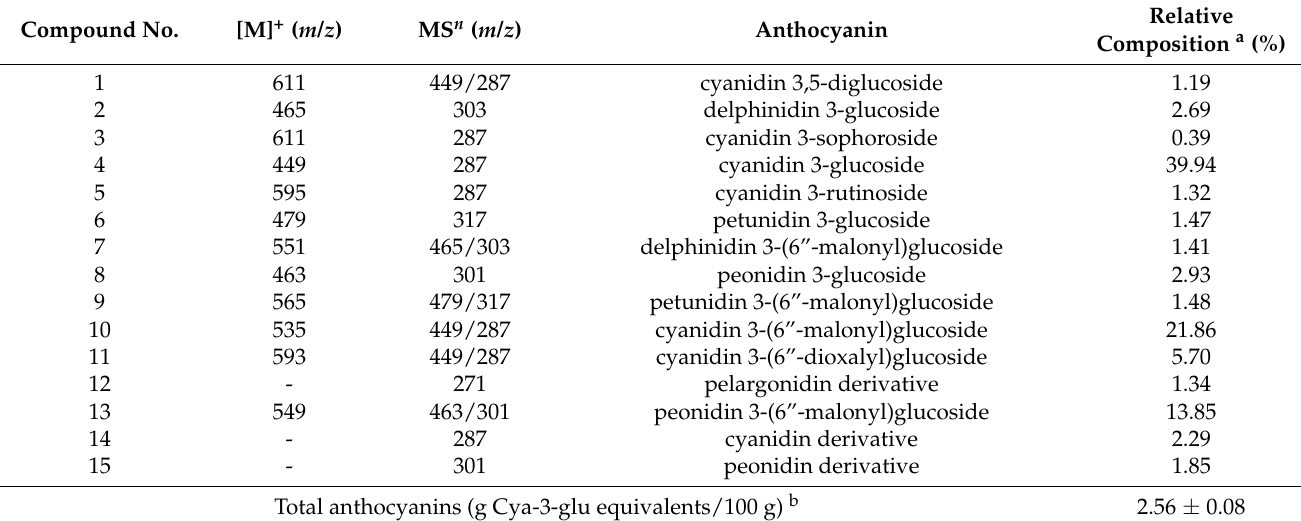
Table 1. Identification and relative amounts of anthocyanins in